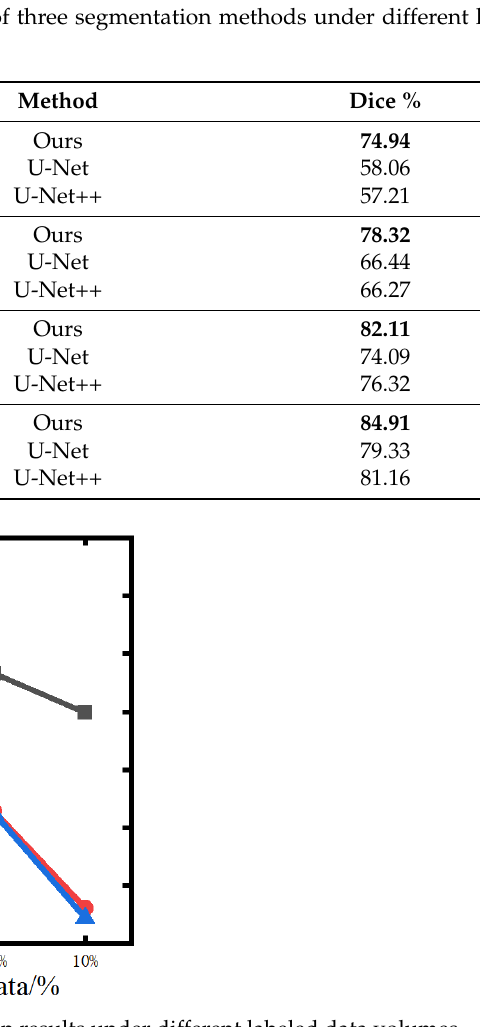
Figure 4. Comparison of lesion segmentation results under different labeled data volumes.